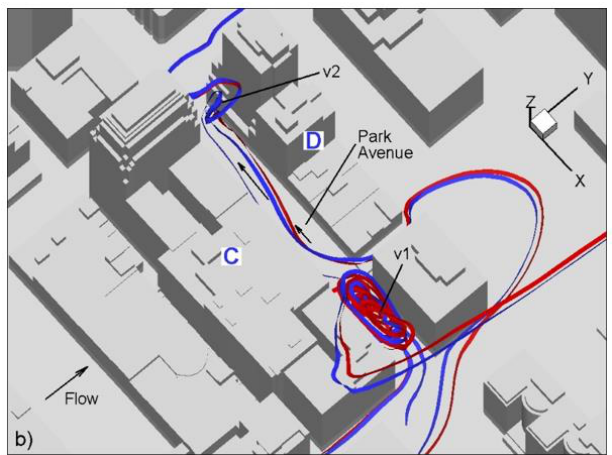
Figure 9. Flow patterns in Park Avenue; a ) 2D streamlines and velocity magnitude contours; b ) 3D streamlines (see the location of Buildings B and C in Figure